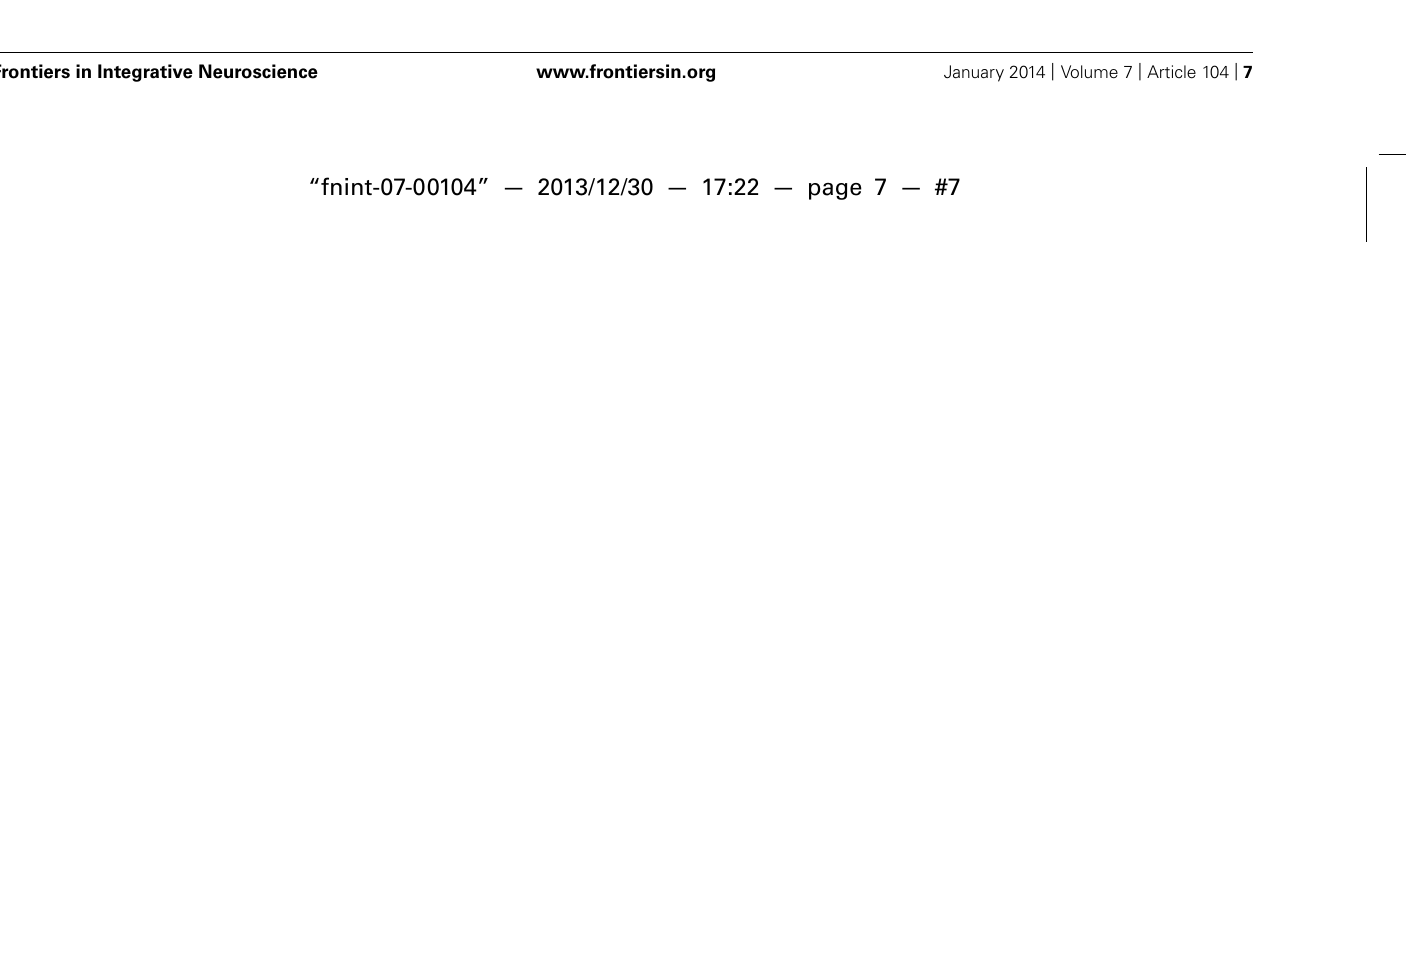
FIGURE 3 | Schematic diagram of thalamic modulation of cingulate seizures. (A) The thalamus innervates both pyramidal neurons and inhibitory interneurons in the cortical area.Thalamic inputs can activate inhibitory interneurons, and the interneurons can in turn silence cortical pyramidal neurons. (B) Epileptiform activity is usually caused by the hyperactivity of some pyramidal neurons.The activation of these pyramidal neurons will also activate the inhibitory interneurons around them, forming surrounding inhibition that can prevent the lateral propagation of epileptiform activity.